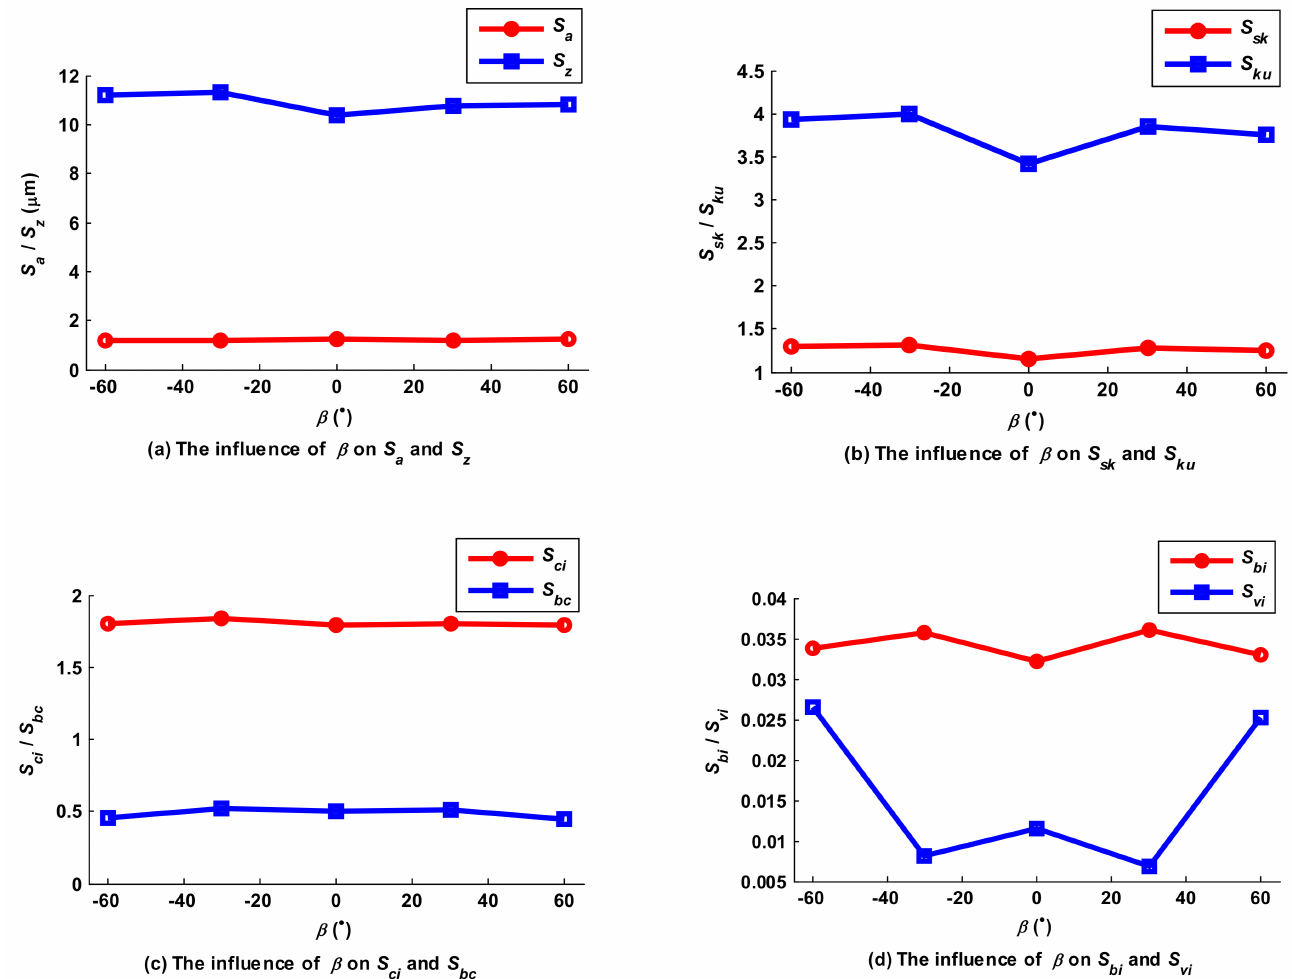
Figure 21. Influence of the lead angle on ball-end trochoidal milling surface